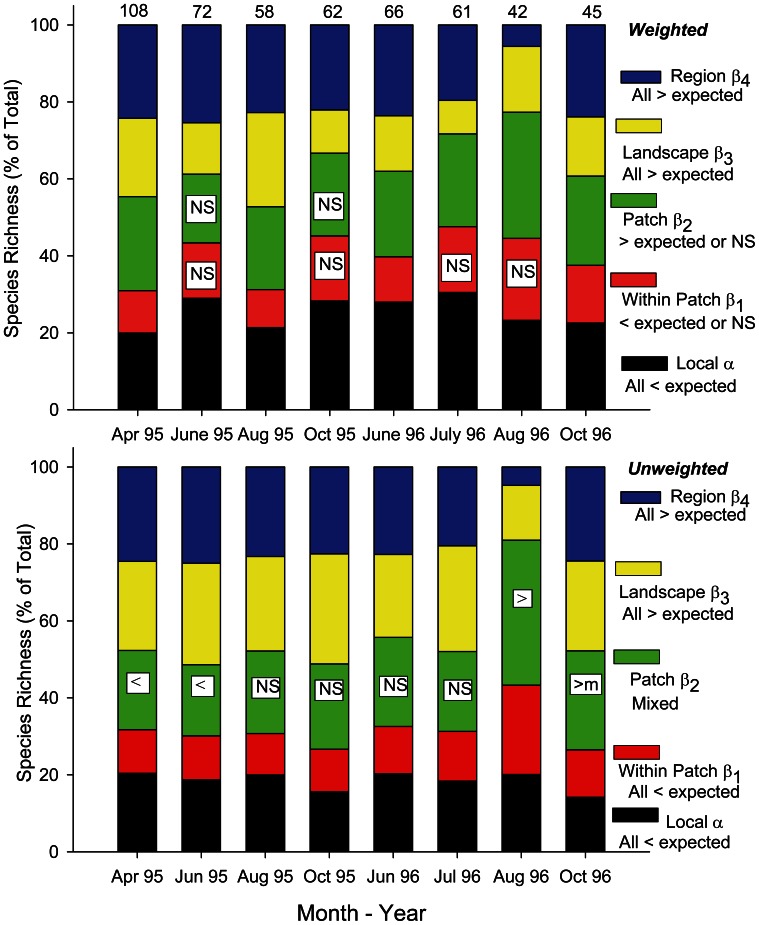
Results of weighted and unweighted additive partitions of species richness across two benthoscapes in Long Island Sound.Randomization test results are given to the right of the figures. “> ” indicates significantly (p<0.05) larger contributions than expected from random to the diversity component at that scale, “< expected indicates significantly smaller contribution; NS indicated not significantly different (p>0.10) from random, m indicates marginally significant (0.05>p<0.10).